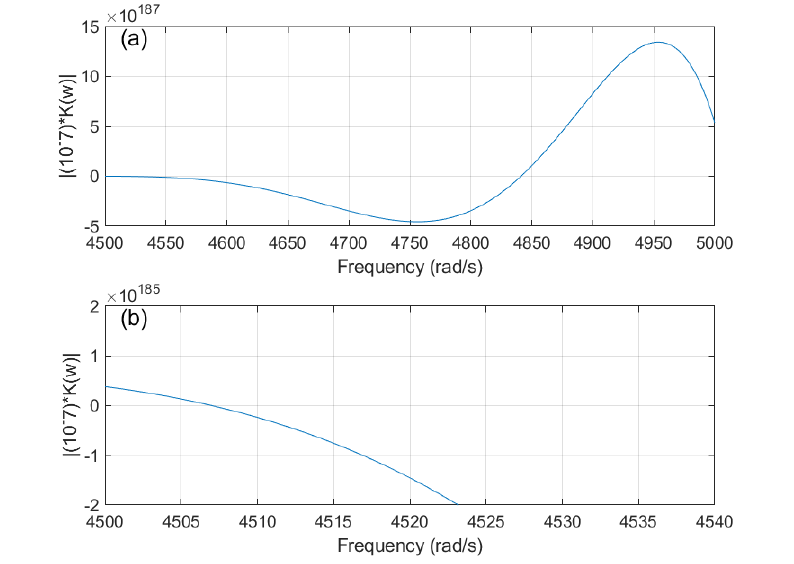
Figure 16. Dynamic Stiffness Matrix plot of Euler–Bernoulli Beams in Topology 1 with unhinged ends using DSM; original configuration ( a ) a selected region of natural frequencies showing zero–crossing at the 10th natural frequency ( b ) a detailed section showing zero–crossing at the 9th natural frequency.